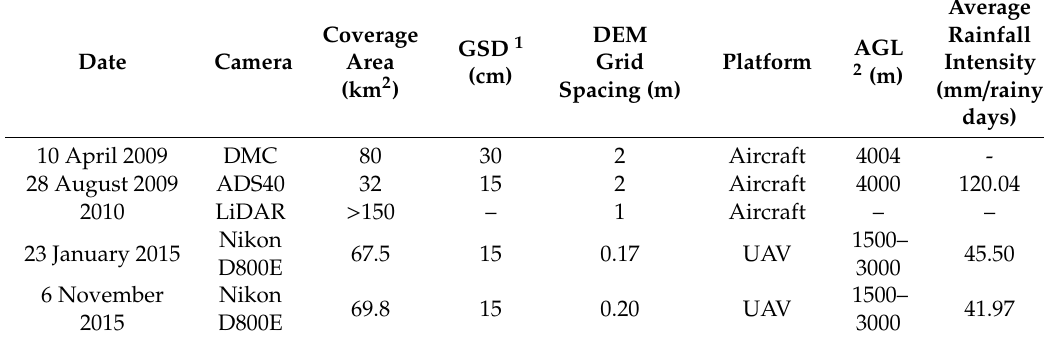
Table 1. Information on the image